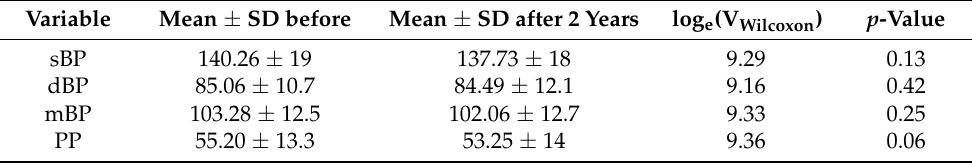
Table 3. Comparison blood pressure before vs. after two years.